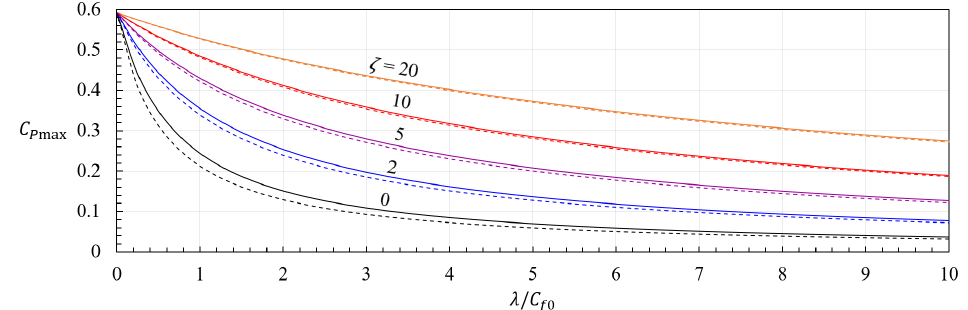
Figure 1. Maximum power coefficient of ideal turbines (actuator discs) in a large wind farm predicted = 4 α ( 1 − α ) and M = 1 + ζ ( 1 − β ) . Solid and dashed by the two-scale momentum theory [6] with C ∗ T lines are for γ = 2 and 1.5,